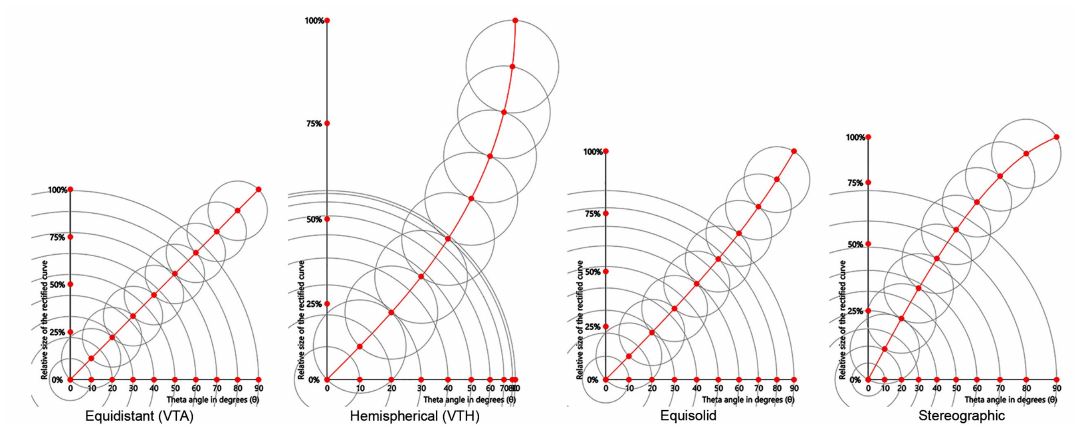
Figure 5. Steps for drawing a rectified curve which represents the hemispherical fisheye projection (Source: the